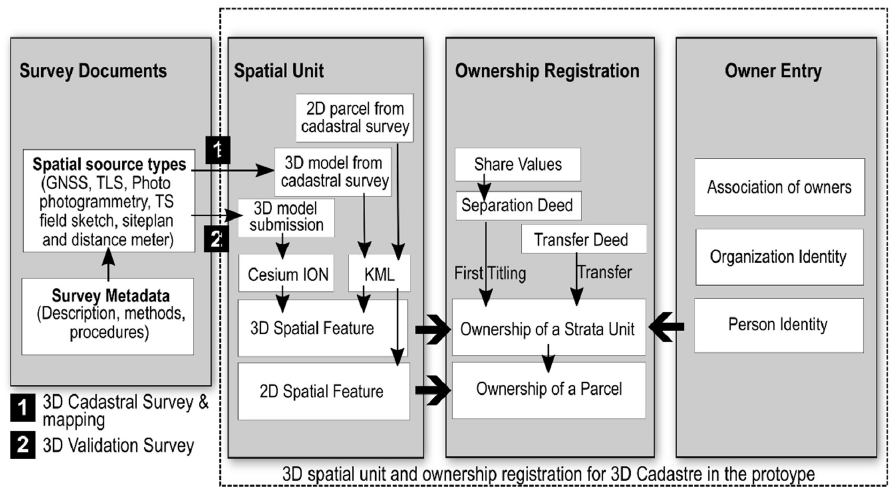
Figure 6. The process model of spatial and legal data storage and linkage in 3D Cadastre of a strata unit registration.